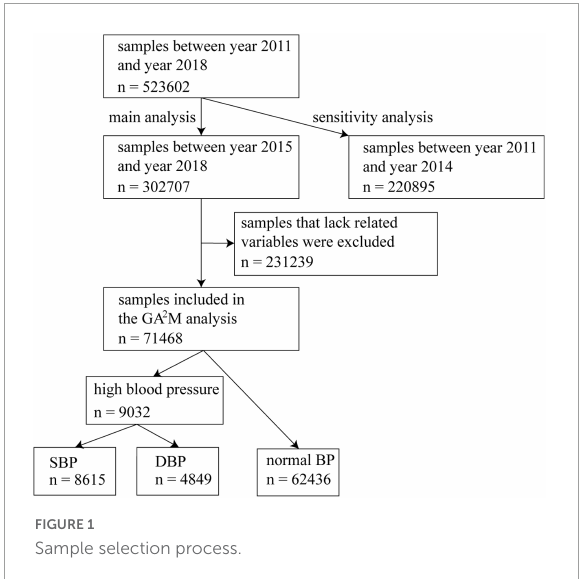
FIGURE1 Sample selection